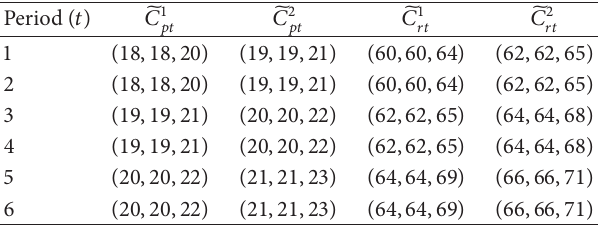
Table 3: Fuzzy unit production cost and labour cost.